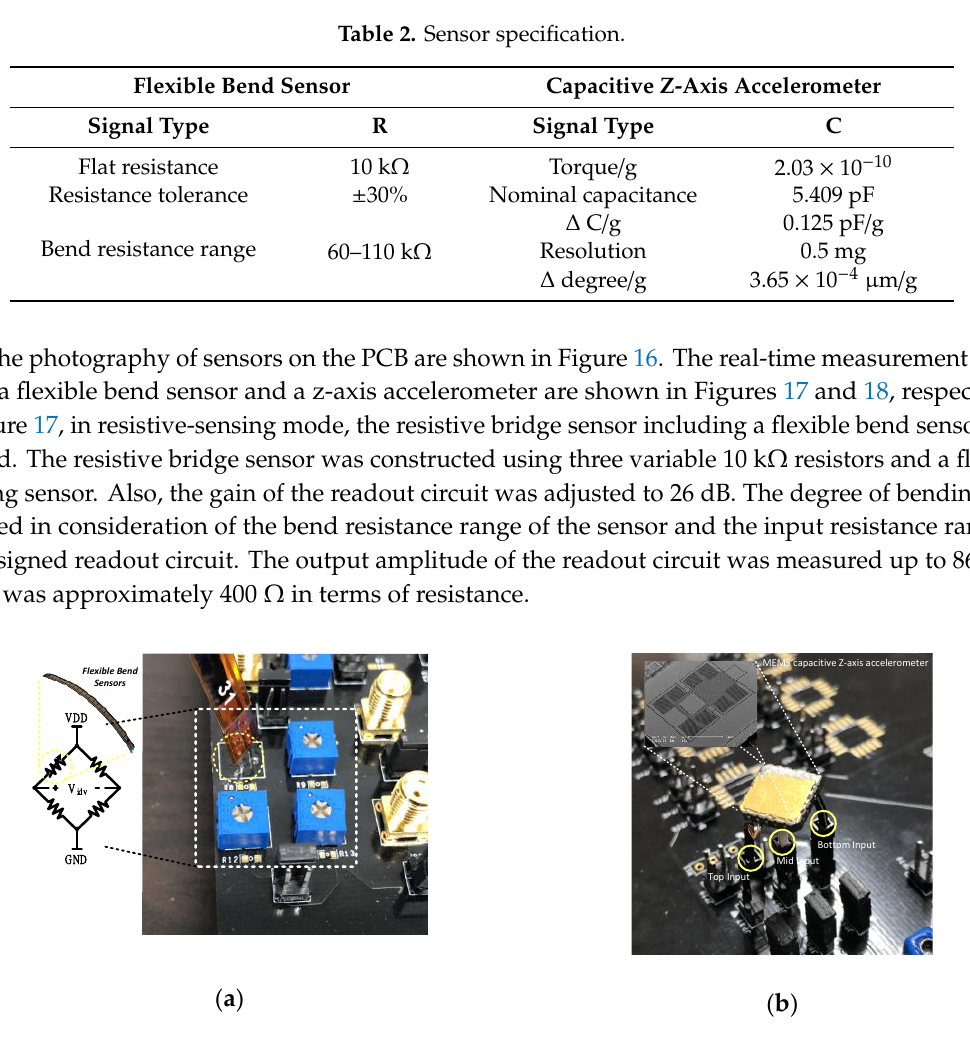
Figure 16. ( a ) Photograph of the flexible bend sensor on a PCB. ( b ) Photograph of a z-axis accelerometer on a PCB.